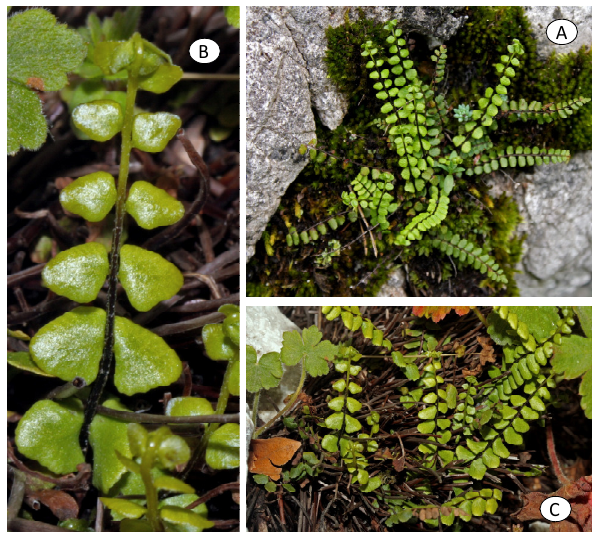
Fig. 1. A: Habitus of Asplenium adulterinum , growing on limestone rocks, near Şugăului Gorges (original photo by Ioana Popescu); B, C: Habitus of Asplenium adulterinum , growing on limestone rocks, in Ţesna Valley (original photo by Adrian